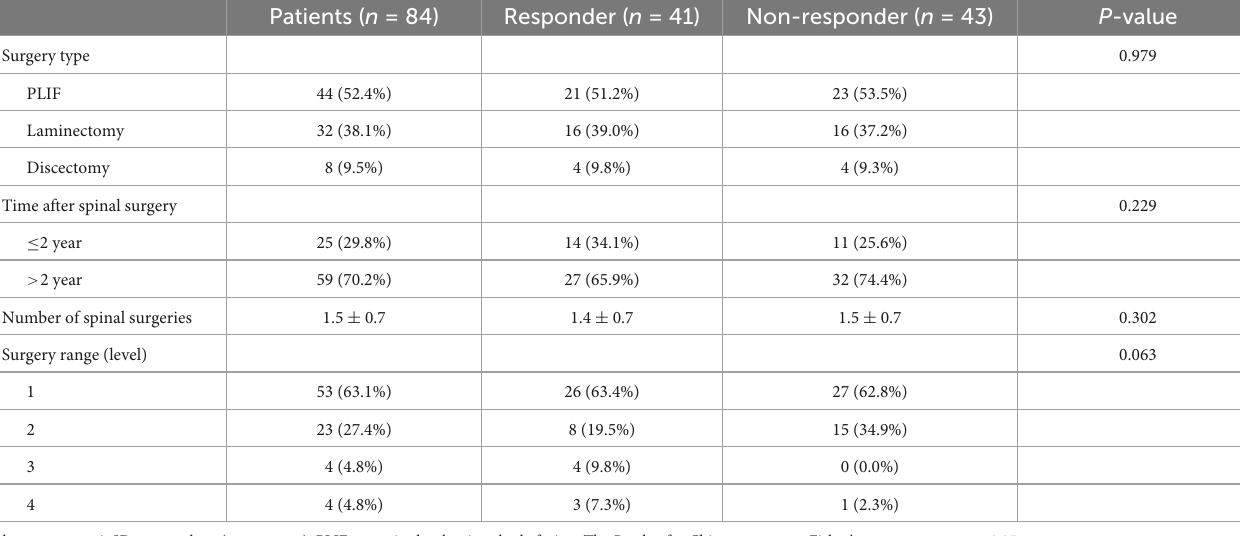
TABLE 3 Fluoroscopic data of lumbar sympathetic ganglion block and clinical outcomes over time.